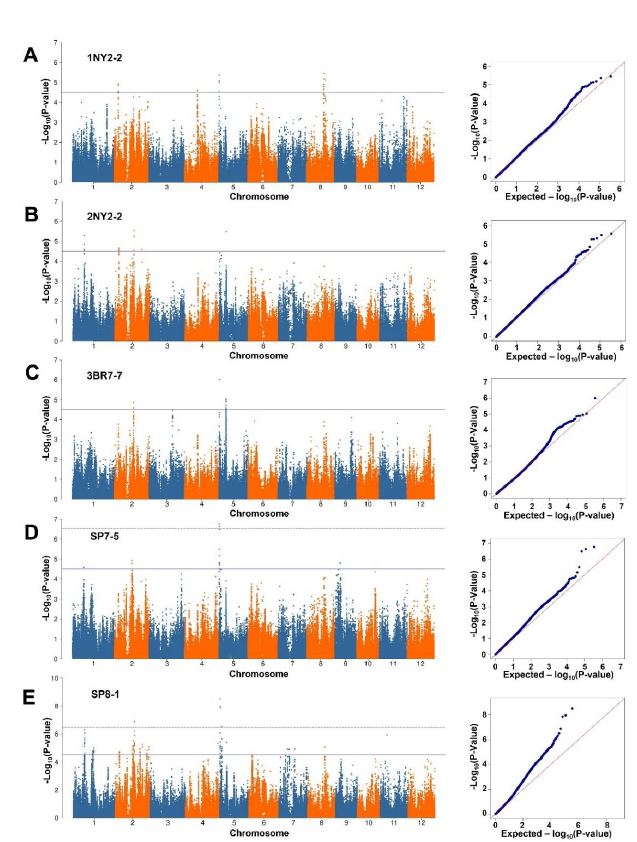
Figure 3. Manhattan and quantile-quantile plots resulting from the genome-wide association study (GWAS) results for BLS disease against five Xoc isolates: ( A ) 1NY2-2, ( B ) 2NY2-2, ( C ) 3BR7-7, ( D ) SP7-5 and ( E ) SP8-1. The cut-off threshold at −log10 ( p ) of 4.5 is indicated by black line and the Bonferroni threshold is indicated by dotted line.